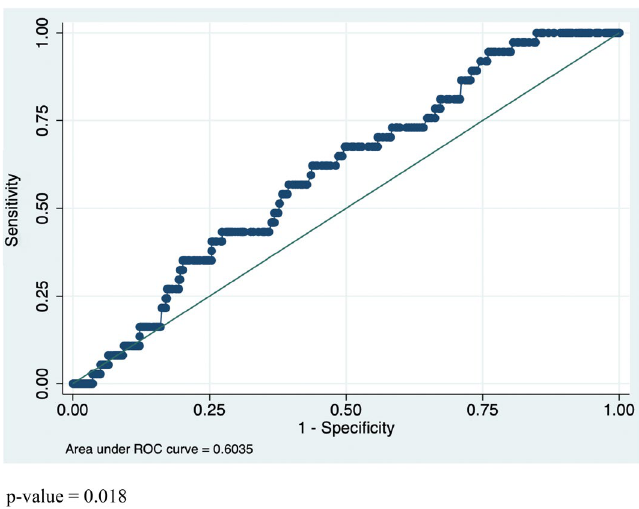
Figure 2. ROC curve for peak serum